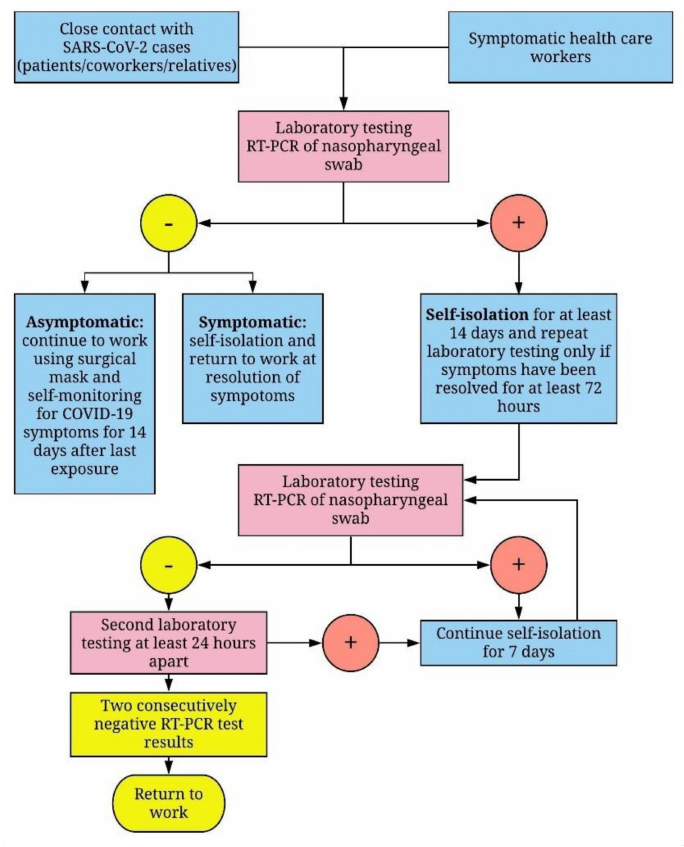
Figure 1. Flowchart for the management of healthcare workers (HCWs) with suspected or confirmed SevereAcuteRespiratorySyndromeCoronavirus2(SARS-CoV-2)infection. Accordingtotheprocedures implemented by Fondazione IRCCS Ca’ Granda Ospedale Maggiore Policlinico in Milan, all HCWs suspected of SARS-CoV-2 infection must be tested by RT-PCR analysis of nasopharyngeal swabs and, if necessary, put into isolation for at least 14 days. The following criteria had to be met for discontinuation of quarantine: (a) resolution of respiratory symptoms and an apyretic state lasting longer than 72 h, and (b) two consecutively negative RT-PCR test results obtained on swabs collected at least 24 h apart. The same procedures were used for asymptomatic HCWs, with the exception of criteria